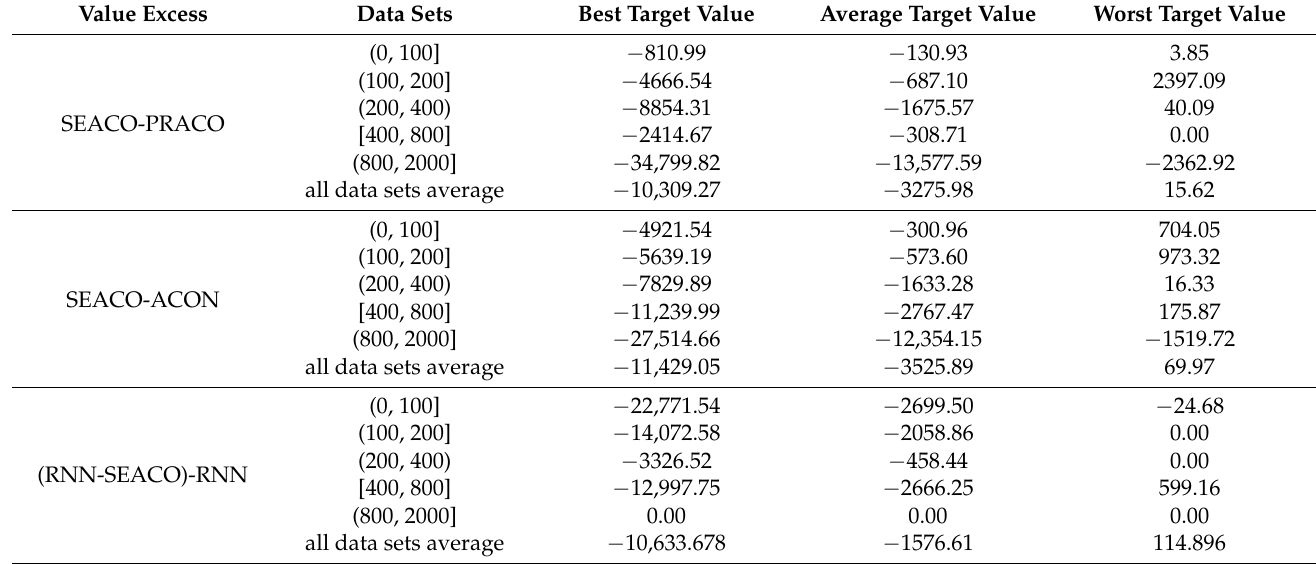
Table 6. The target value of SEACO algorithm compared with other improved